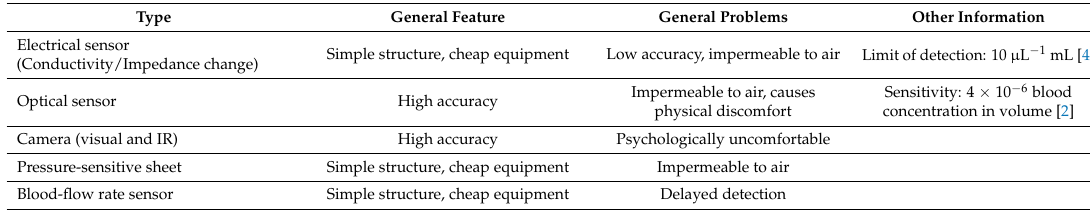
Table 1. Comparison of blood leakage sensor